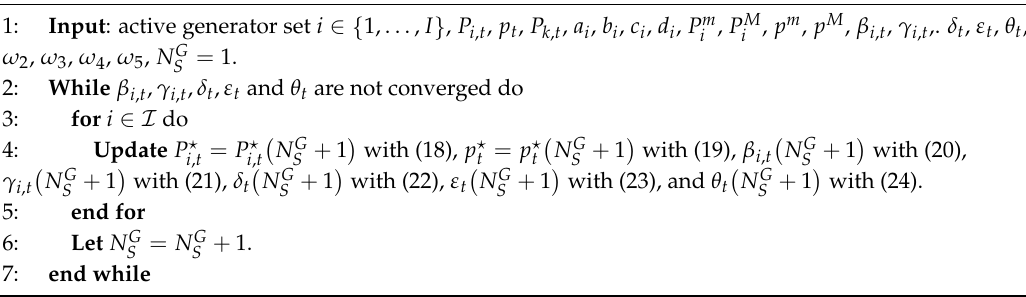
Algorithm 3. Slave-loop Algorithm of the Generator’s Profit